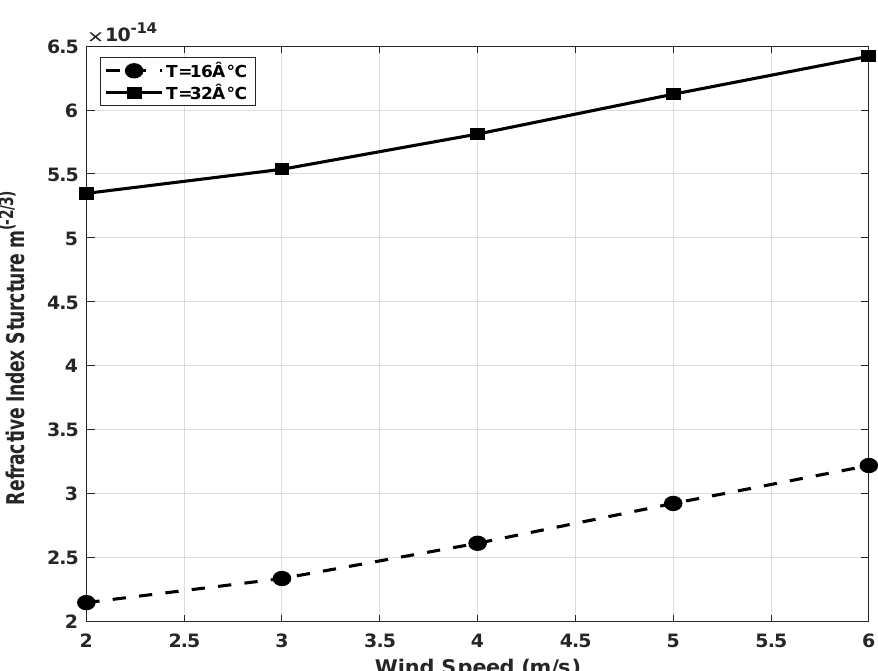
Figure 5. Variation in the Refractive Index Structure with the Wind Speed and